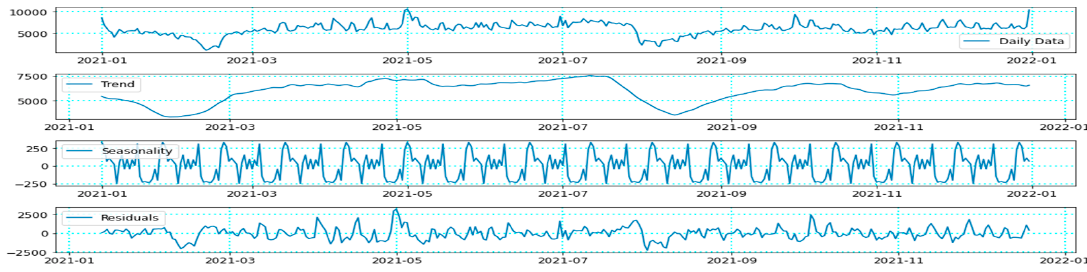
Figure 5. The decomposed plot of the original series.